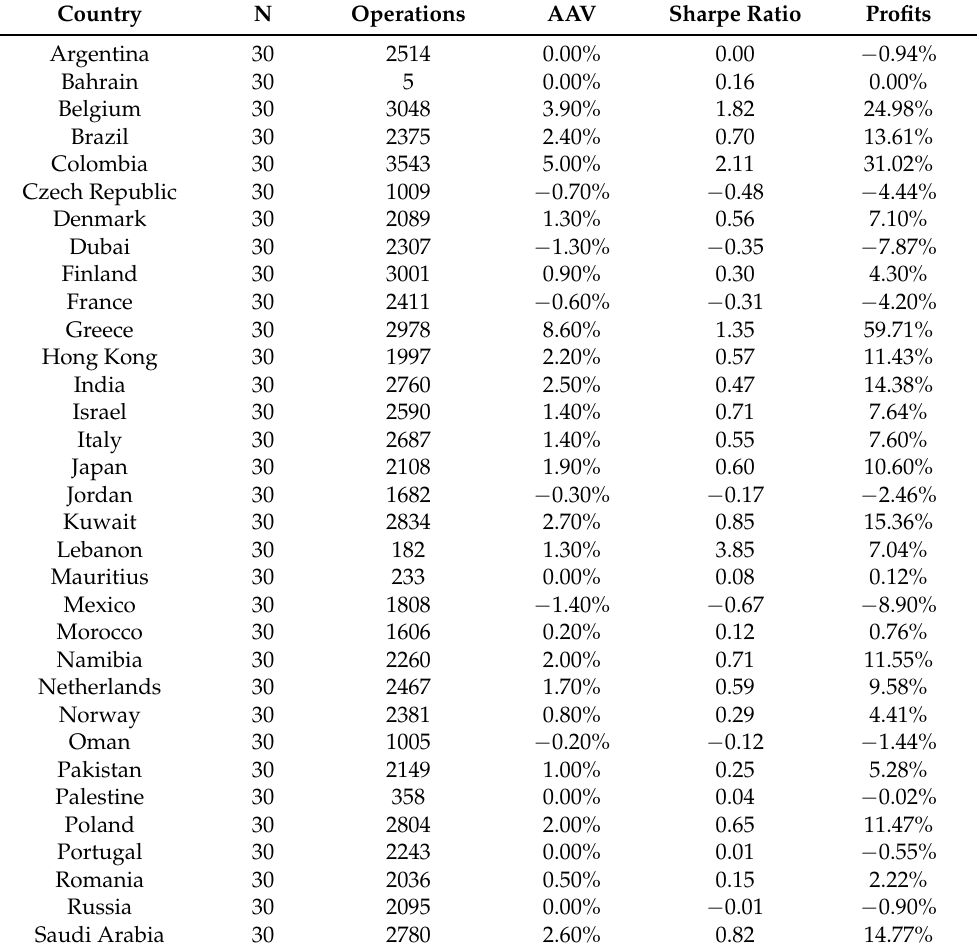
Table A8. Results obtained for the period 2014–2020 (30 Pairs), where N is the number of pairs; AAV Average annualized return; and Profit is the profitability for the full period with transaction